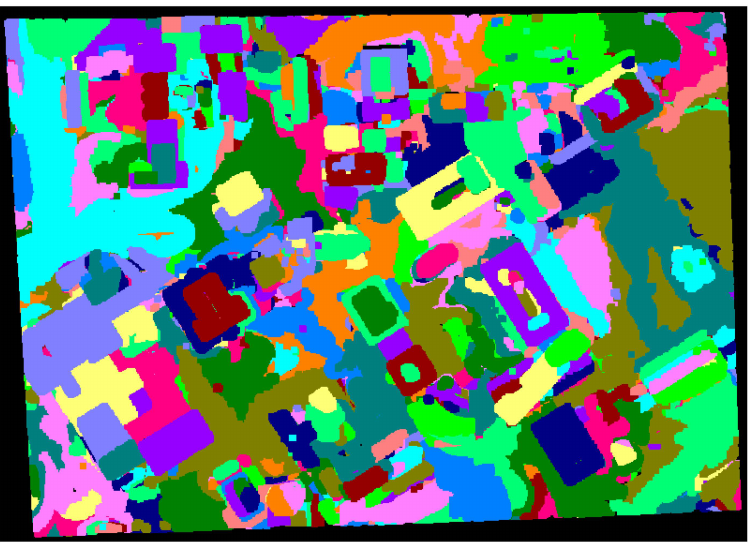
Figure 19. Segmentation results based on the proposed approach over University of